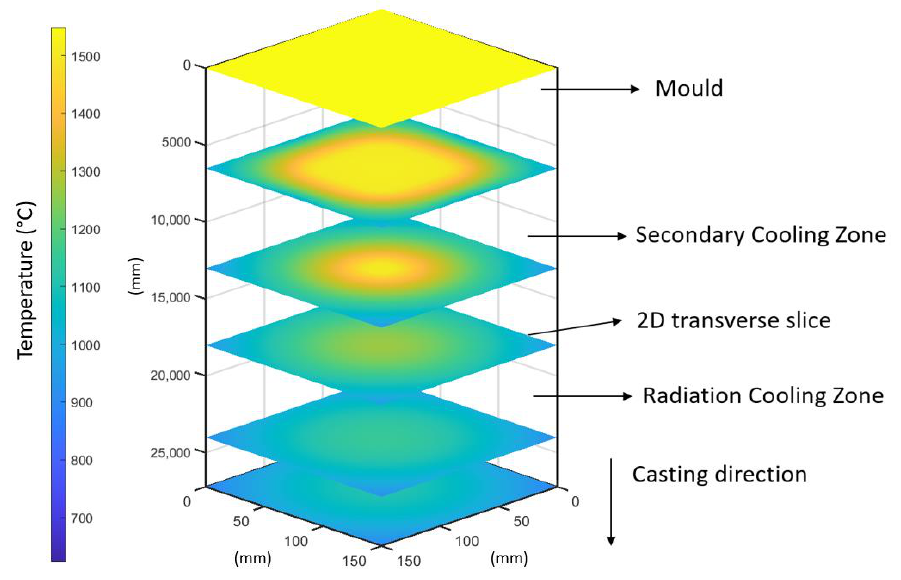
Figure 3. Idea of the 2.5D slice model.